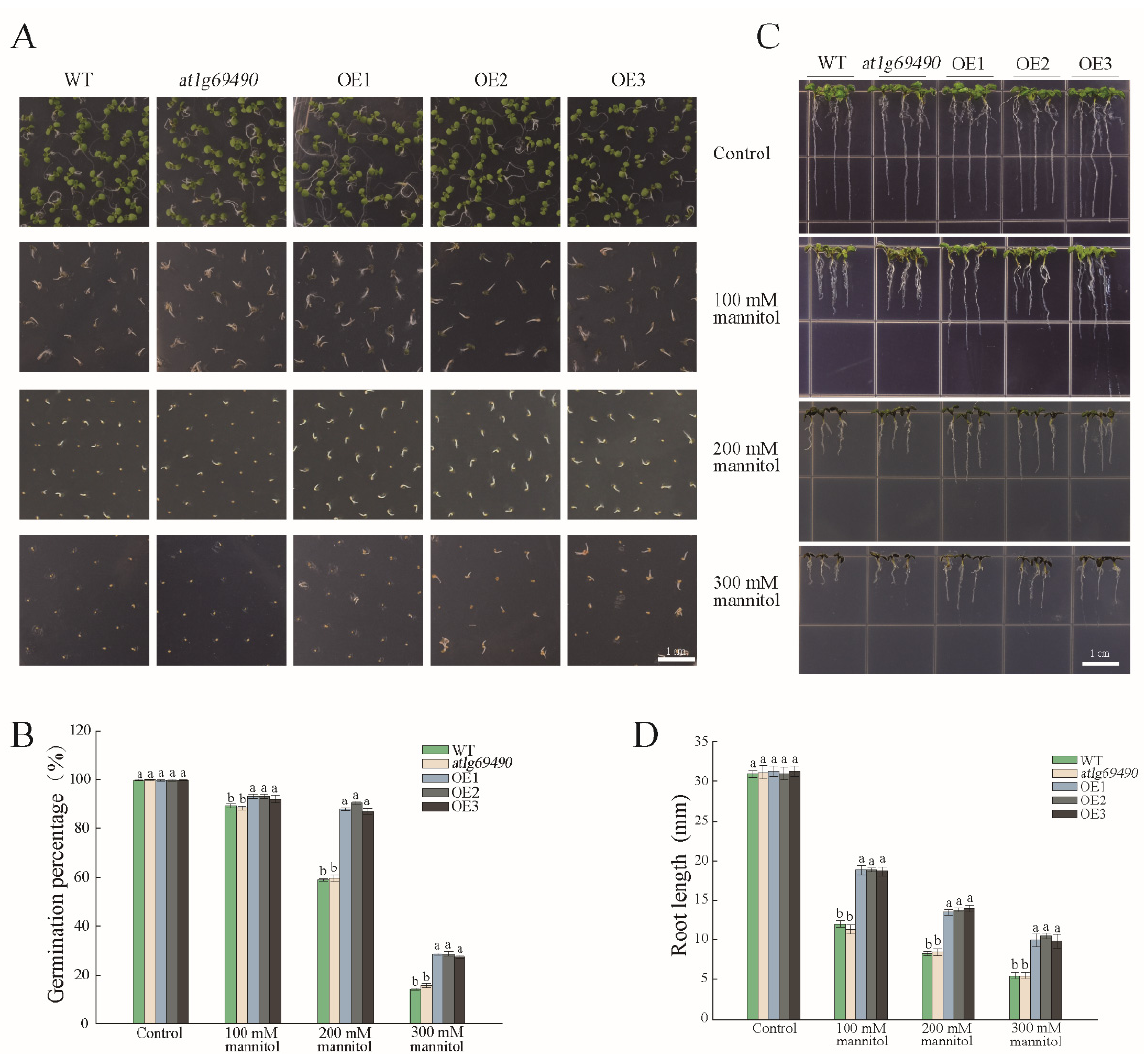
Figure 3. Overexpression of PwNAC38 significantly improved drought tolerance in seed germination and root elongation in Arabidopsis . Observation ( A ) and statistics ( B ) of germination percentage under mannitol treatment. Observation ( C ) and statistics ( D ) of root length under mannitol treatment. The significantly different mean values at p ≤ 0.05 were labeled by different letters.